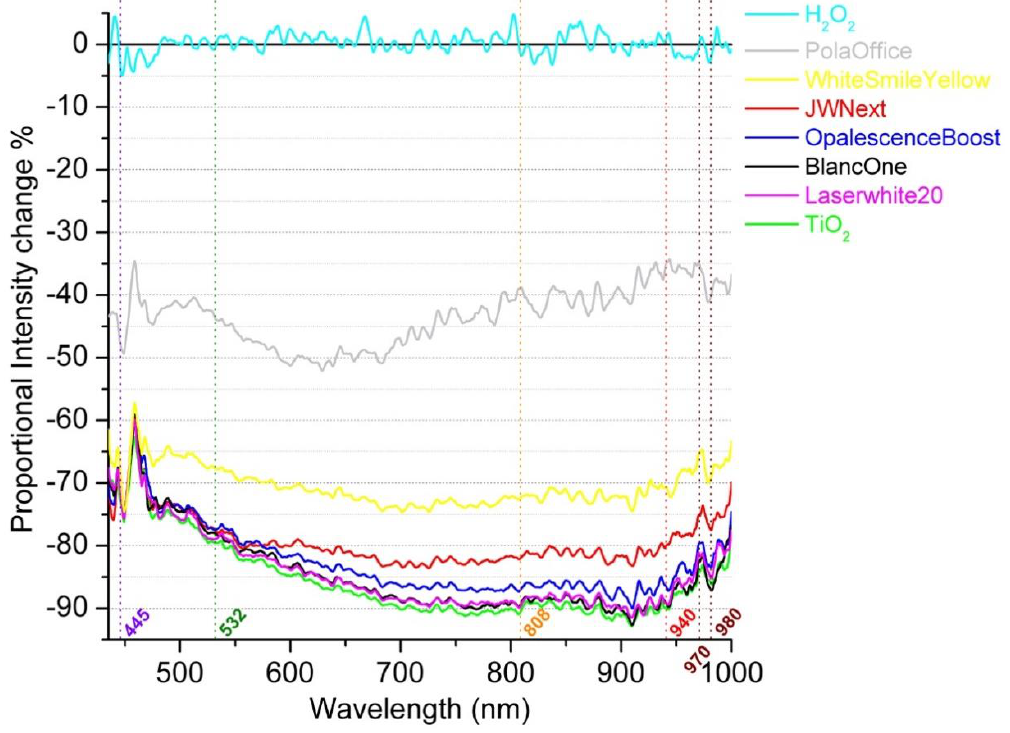
Figure 2. Light attenuation curves (average spectra) of all bleaching gels and H 2 O 2 analysed. The light source used was a halogen lamp. The abscissa axes represent the range of laser wavelengths that are commercially available in dentistry.